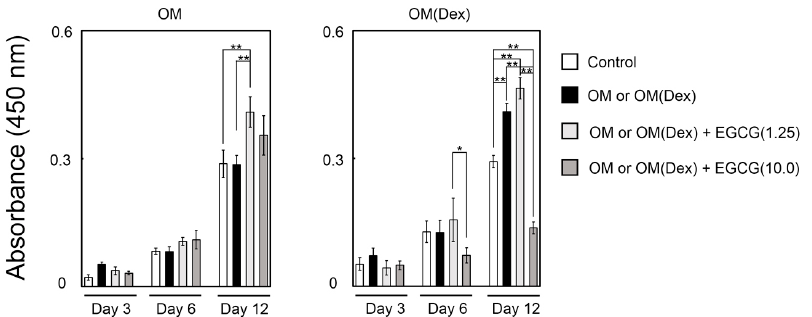
Figure 1. Results of the cell proliferation assay. OM: osteogenic medium without Dex; OM(Dex): OM with 100 nM Dex. Control: control medium. Cells were seeded in condition 1 and were subjected to EGCG in OM or OM(Dex). N in EGCG(N): concentration of EGCG ( µ M). * p < 0.05, ** p < 0.01 (Analysis of variance (ANOVA) with a Tukey–Kramer test). The bar graph shows the mean with standard deviation ( n = 4).